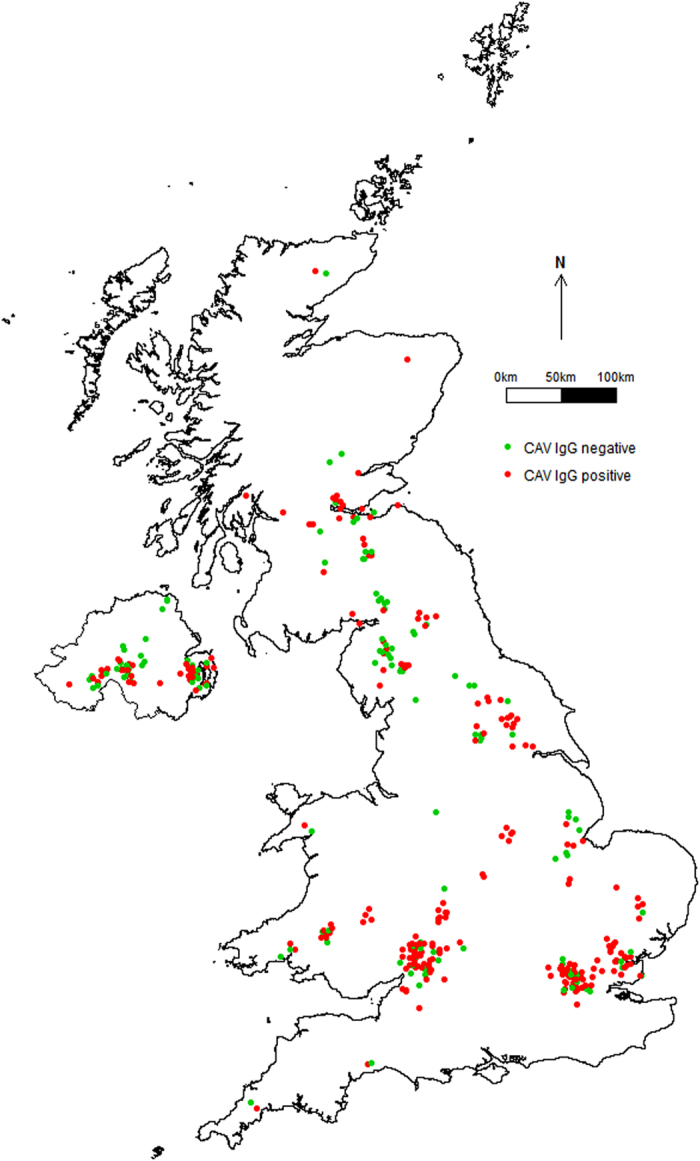
Spatial distribution of red foxes sampled in the United Kingdom (n = 387), according to canine adenovirus (CAV) IgG status.Jittering of data points was applied to improve the differentiation of overlapping data points. The map was created in R2433.